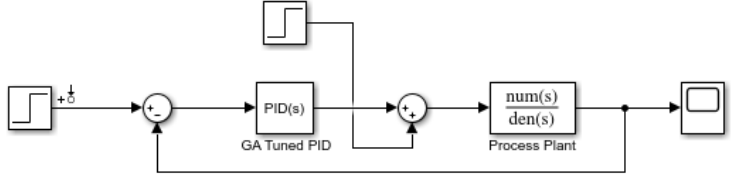
Figure 1. GA tuning PID control system of the wind tunnel flow field.